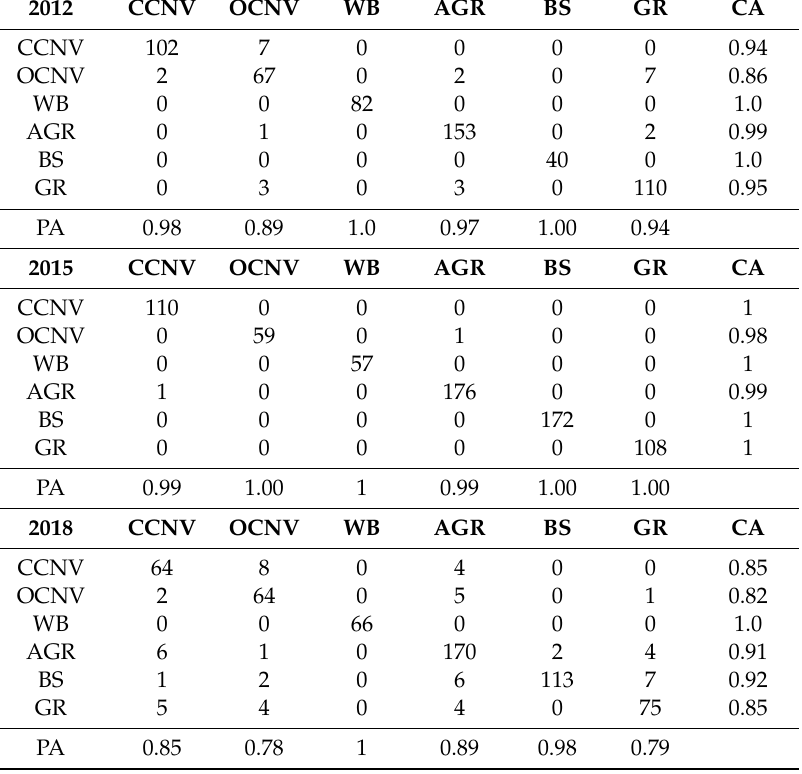
Table 6. Confusion matrix of classification for the years 2012, 2015, and 2018. CCNV—close canopy natural vegetation; OCNV—open canopy natural vegetation; WB—water bodies; AGR—agriculture; BS—bare soils; GR—grassland; PA—producer accuracy; CA—consumer